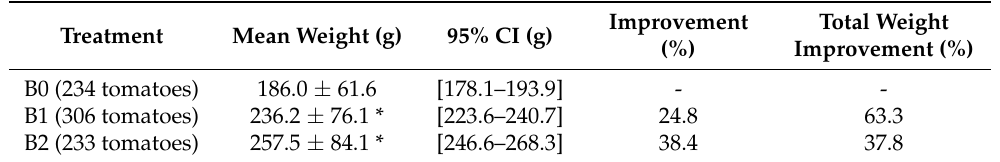
Table 5. Mean tomato weight in each treatment, expressed as mean ± standard deviation, with 95% CI standing for confidence interval at p = 0.05. * Significant difference p < 0.01.